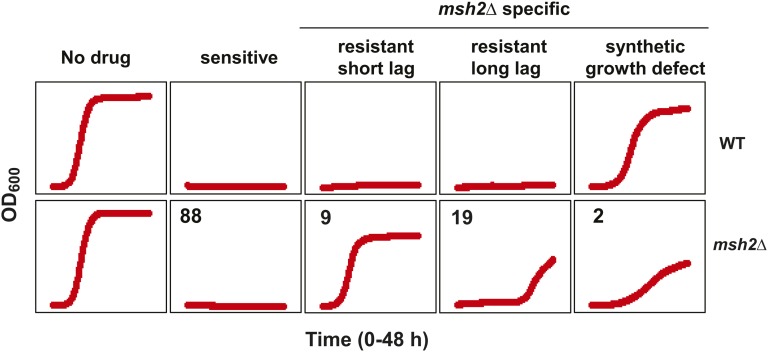
Examples of the effects of compounds of interest from the small molecule screening. Representative growth curves of erg6∆ pdr5∆ wild-type (WT) and msh2Δ erg6∆ pdr5∆ (msh2Δ) strains in the absence of a drug (DMSO control, No Drug), in the presence of a drug that inhibited the growth of both strains (sensitive), in the presence of 400 μM etoposide (resistant, short lag) or 100 μM camptothecin (resistant, long lag), or in the presence of 60 μM bactobolin (synthetic growth defect). Optical density readings at 600 nm (OD600) were taken every 15 min for 48 hr using a Biotek Plate Reader. The number of compounds remaining in each category after the screening process is indicated in the upper left of each panel of the msh2Δ curves. The three rightmost panels are representative of molecules resulting in an msh2∆-specific growth difference.